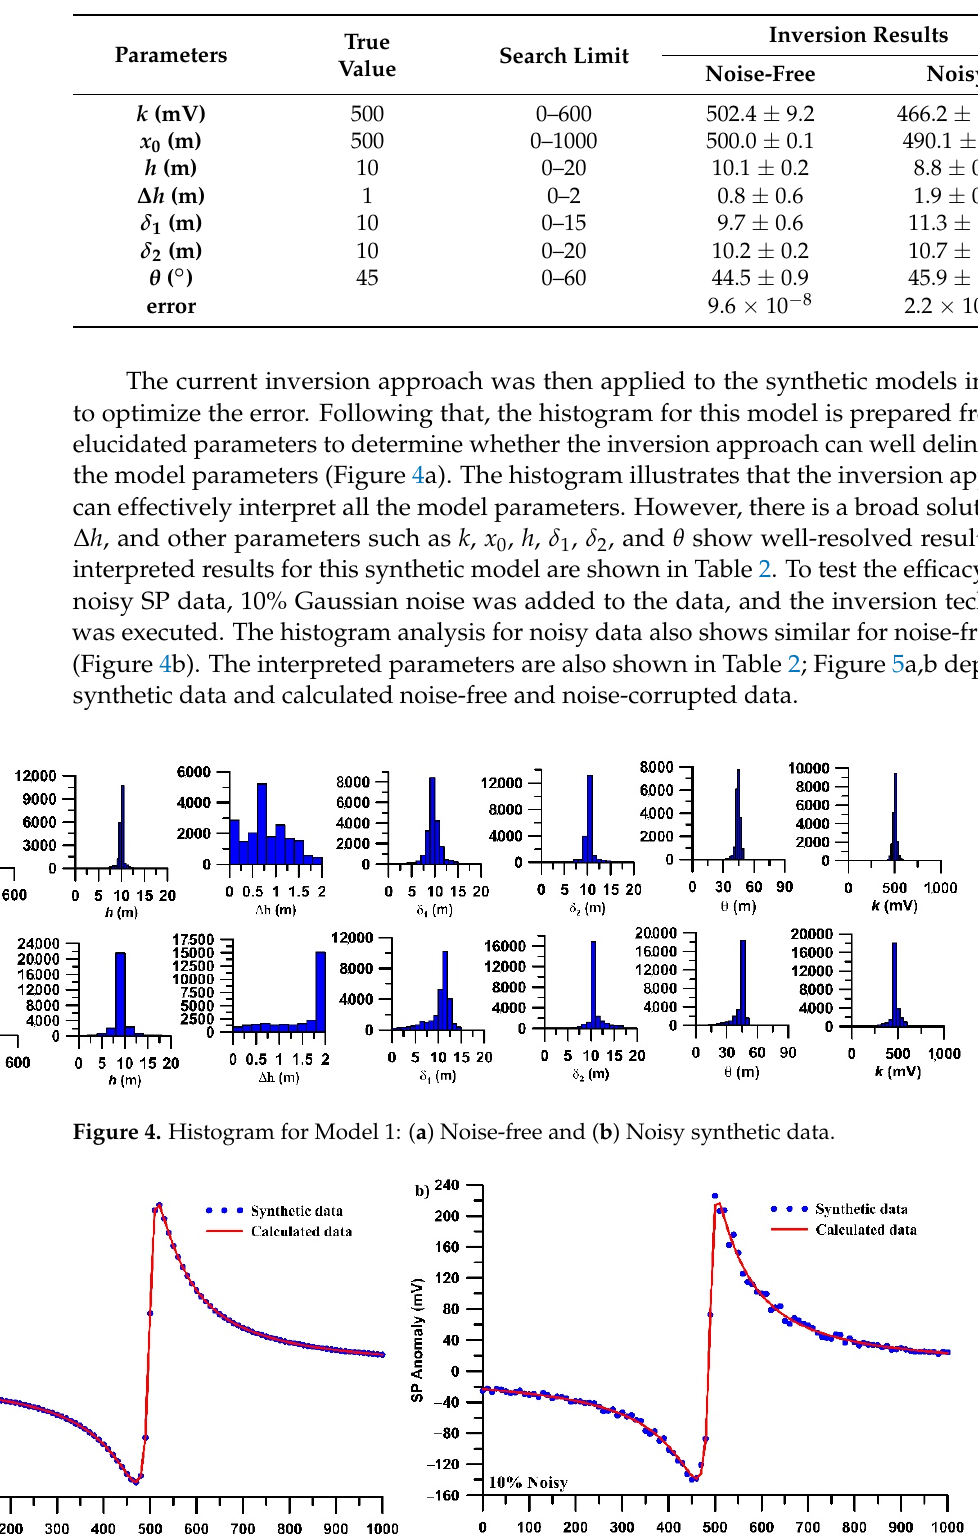
Table 2. Inverted model parameters (Model 1) of synthetic data from 2D dipping layer/bed.